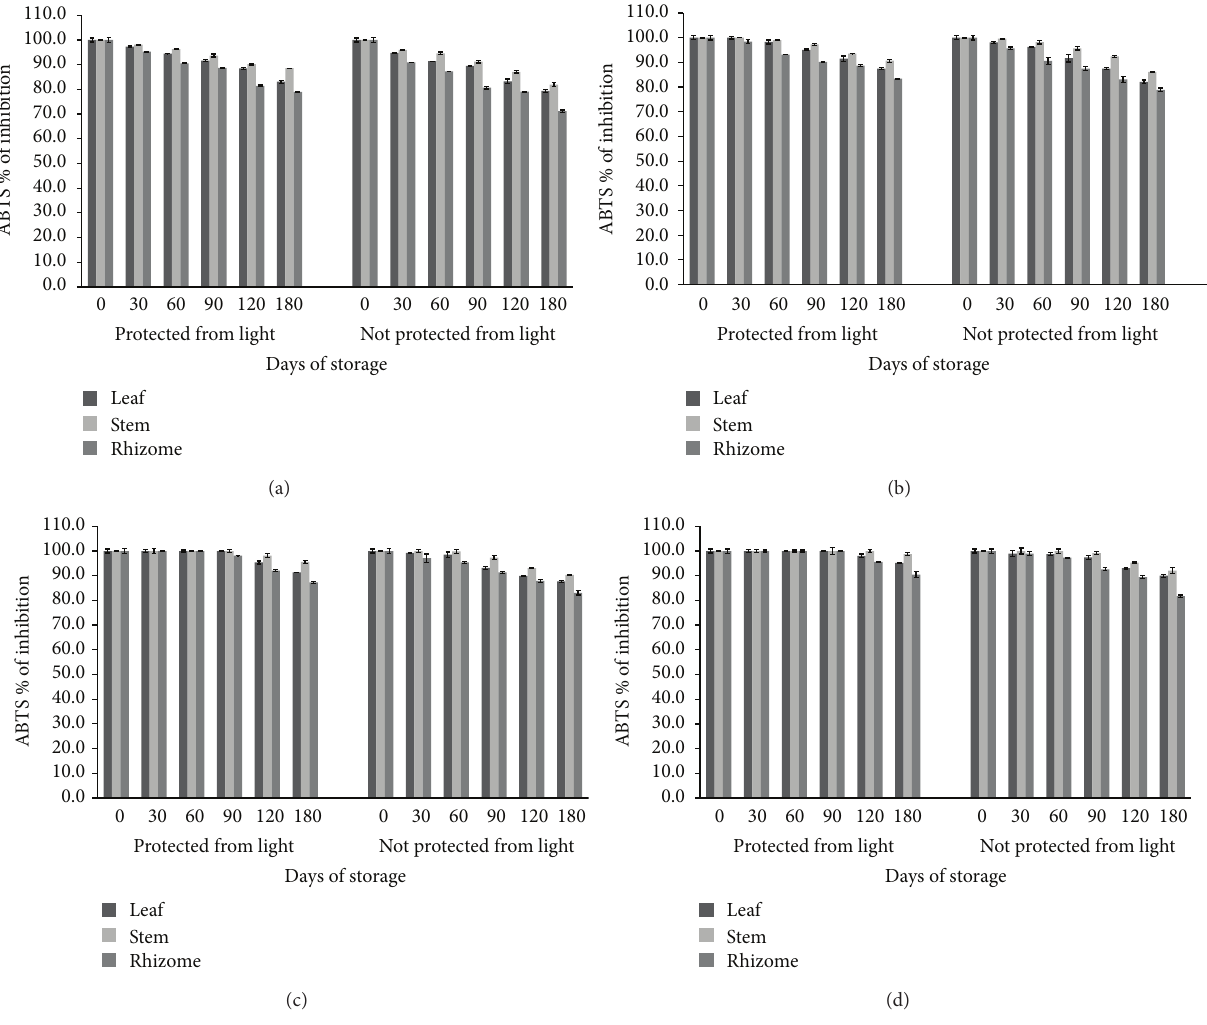
Figure 2: 2,2 󸀠 -Azino-bis(3-ethylbenzothiazoline-6-sulfonic acid) (ABTS) % of inhibition from extracts of Anemopsis californica . Storage during 180 days of storage at 50 (a), 25 (b), 4 (c), and − 20 ∘ C (d), protected and not protected from light. amount of total phenols and flavonoids, nor of antioxidant activity, in comparison with stem and rhizome